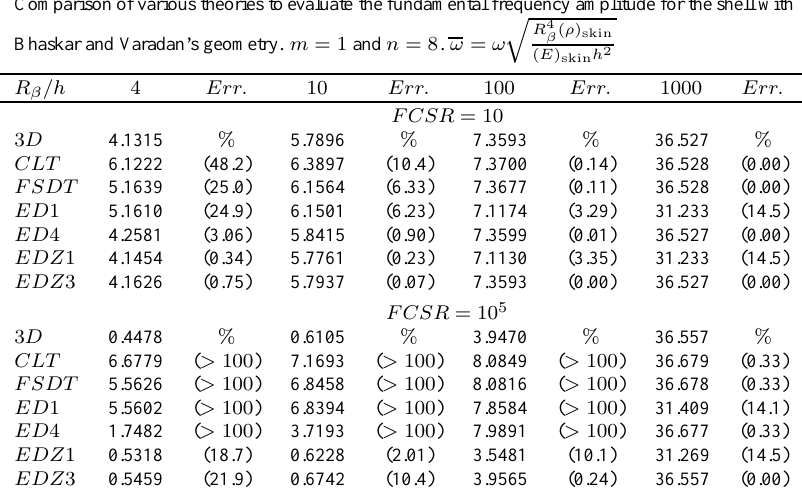
Table 6 Comparison of various theories to evaluate the fundamental frequency amplitude for the shell with Bhaskar and Varadan’s geometry. m = 1 and n = 8 . ω =